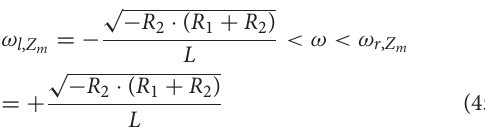
FIGURE 16 | Loci of the real (A) and imaginary (B) parts of the local impedance Z m ( j ω ) of the NbO memristor vs. the angular frequency ω at the memory state operating point X 478, corresponding to the NDR current-voltage bias point Q m ( V m , I m ) (0.937V,5.948mA). (C) = = = (A,B) , with arrows indicating the evolution of the trajectory point along the Nyquist plot as the angular frequency increases from ω l , Z 18.305Mrad s − 1 . It follows that, under current control, the memristor is locally active and stable ), where ω r , Z , ω r , Z impedance is negative for ω ( ω l , Z m = m = − m m · ∈ at the state operating point X 478, and, as a result, it is said to poised on the EOC =